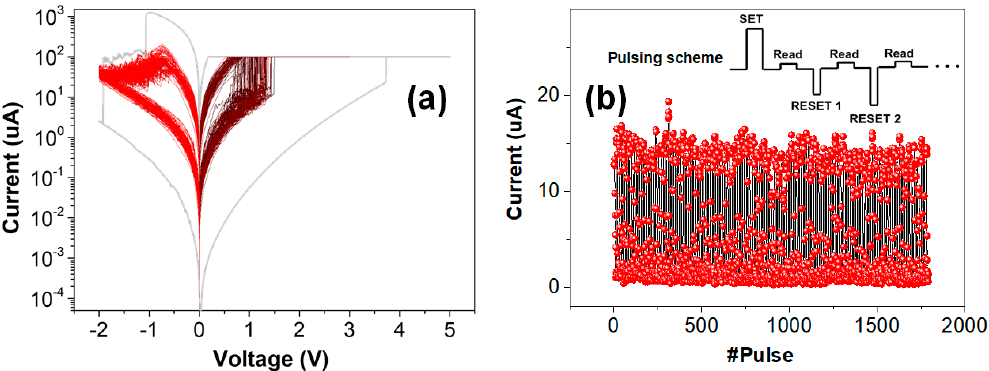
Figure 13. ( a ) DC I-V characteristics of HfO x -based RRAM device with abrupt SET and gradual RESET behavior. The grey curve indicates the forming process on the pristine device. ( b ) Endurance cycling performed with a single SET pulse and multiple RESET pulses ( − 1.2 V to − 2.2 V with 0.2 V interval) for each cycle.